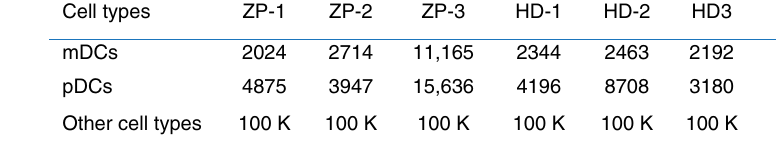
Fig. 1 Transcriptional signatures of immune cell subpopulations during naturally acquired ZIKV infection. a Principal component analysis of global transcriptional signatures from indicated cell populations derived from ZIKV-infected (positive) and ZIKV-noninfected (negative) control individuals. b Bar diagram indicating the total number of upregulated and downregulated genes in indicated cell populations from ZIKV-infected patients, relative to noninfected individuals (FC = 1.5, FDR < 0.05). c Numbers of cells sorted for indicated cell populations from ZIKV-infected patients and noninfected individuals. d Heatmaps demonstrating transcriptional patterns of top100 differentially expressed genes (DEGs) between ZIKV-infected individuals and noninfected individuals in indicated immune cell subsets (left panel). Volcano plots demonstrate fold change (FC) in expression intensity of DEGs, plotted against corresponding p -values (right